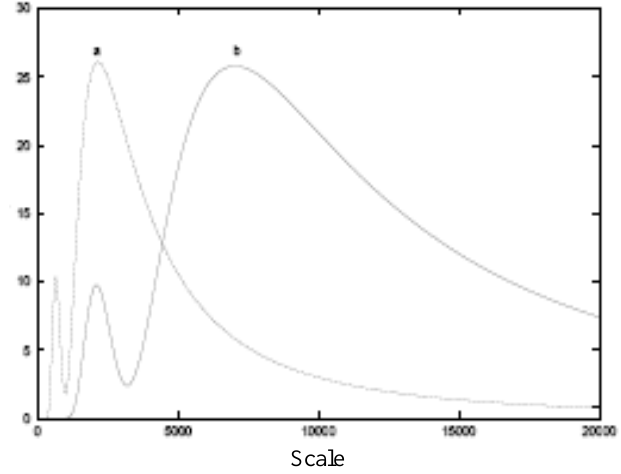
Scale Fig. 2. Wavelet spectrum of NSE (curve a) and BSE (curve b)